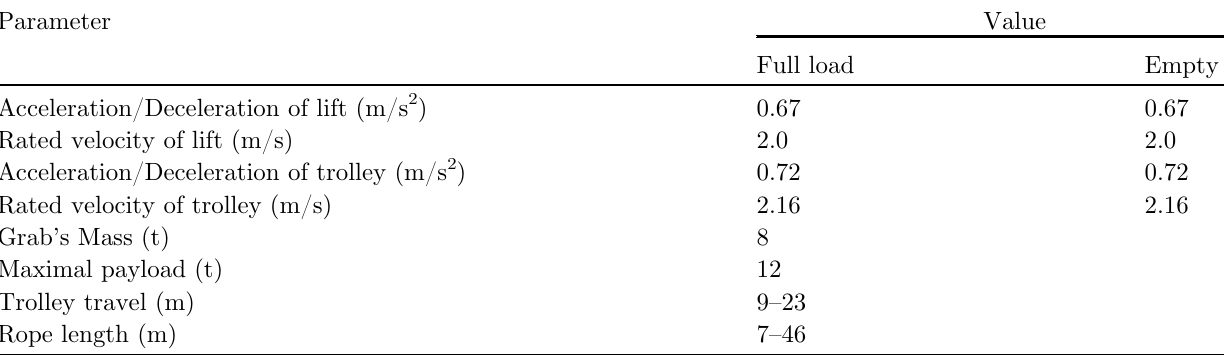
Table 1. Main parameters of a 800 t/h grab ship unloader.